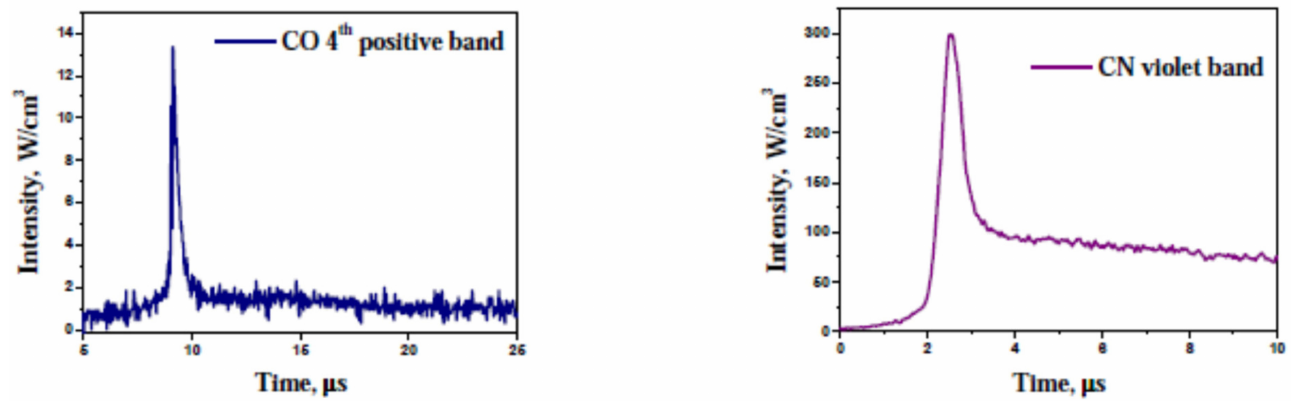
Figure 58. CO(4+) and CN violet bands for Case 5 of Table 6 (from